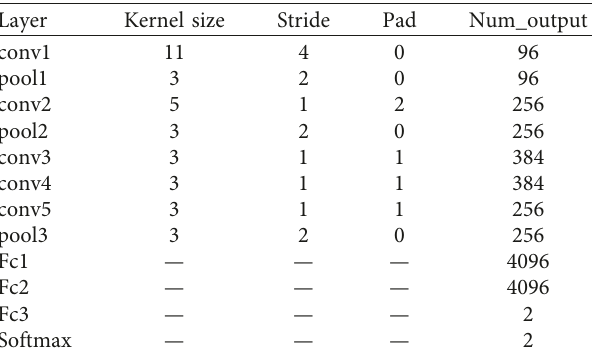
Figure 2: Illustration of a CNN’s overall architecture. conv# operation. Table 1: Detailed specifications of a